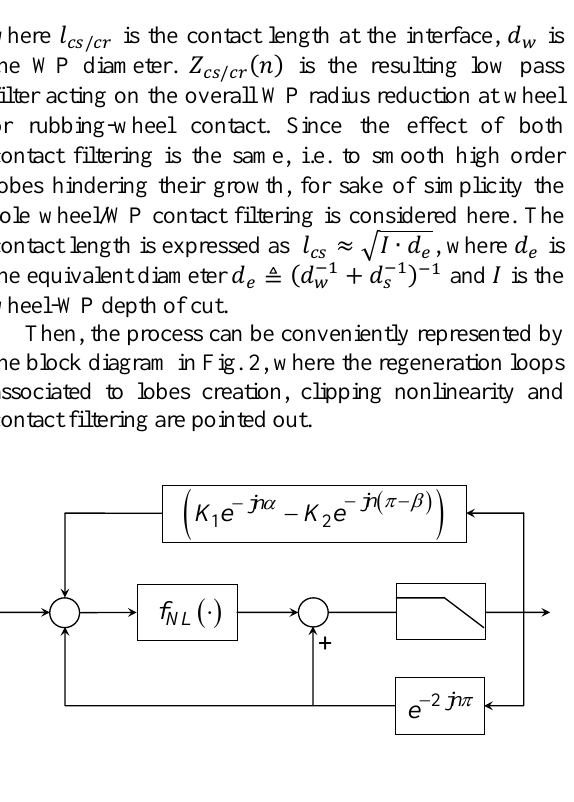
Fig . 2. Block diagram of geometric rounding